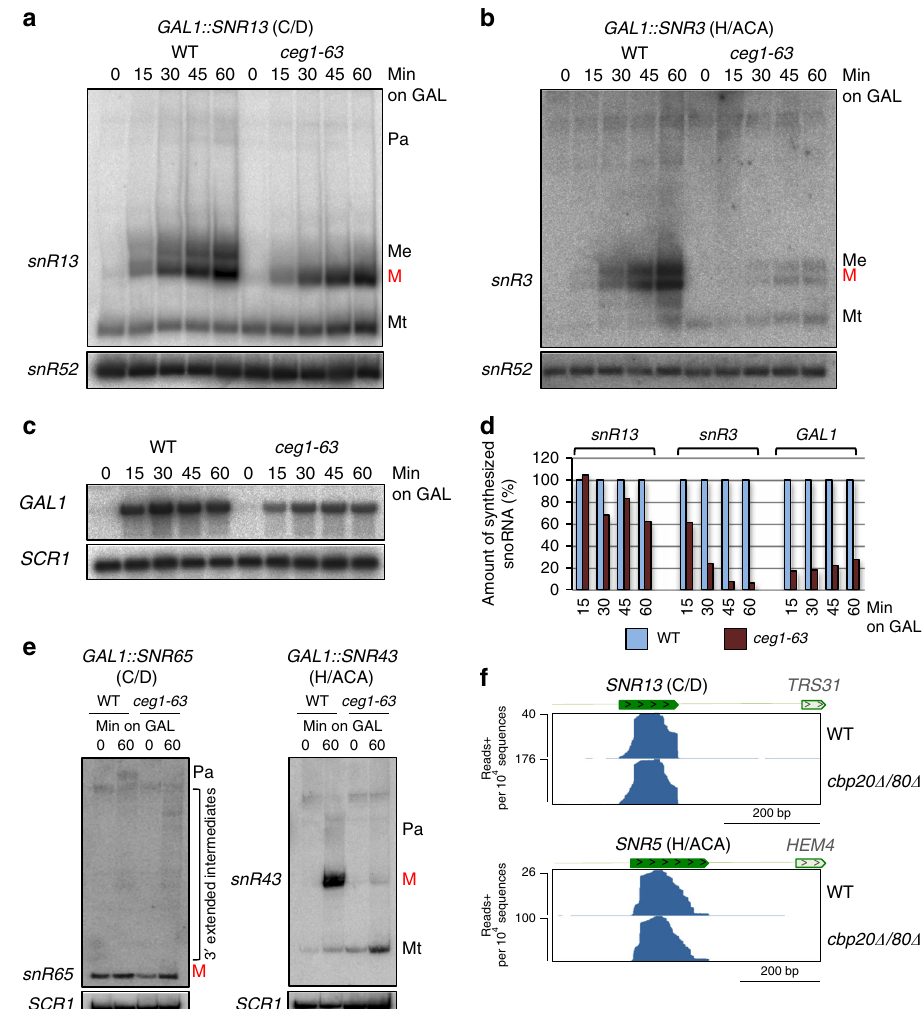
Fig. 2 Box H/ACA but not C/D snoRNA require cap structure. Transcriptional induction of a box C/D SNR13 , b box H/ACA SNR3 c and protein-coding GAL1 in ceg1-63 versus WT strains; Northern blot analysis. Cells were shifted to the non-permissive temperature for 15min prior to galactose induction and were incubated at this temperature during transcriptional pulse. Pa precursors with long polyadenylated 3 ʹ extensions, Me precursors with short oligoadenylated 3 ʹ extensions, M mature, Mt 5 ʹ truncated mature snoRNA. d Quanti fi cation of synthesis rates for snR13, snR3 and GAL1 mRNA in WT and ceg1-63 strains normalised to the loading controls. Values for WT were set to 100%. e Transcriptional induction pro fi les of RD box C/D SNR65 and box H/ACA SNR43 ; mature and precursors snoRNA are marked as above. Northern blot analysis. f RNA-seq analysis of total RNA from cbp20 Δ cbp80 Δ strain. The X axis values are independently adjusted for each sample. Green and light green rectangles denote mature snoRNA and adjacent protein-coding genes,